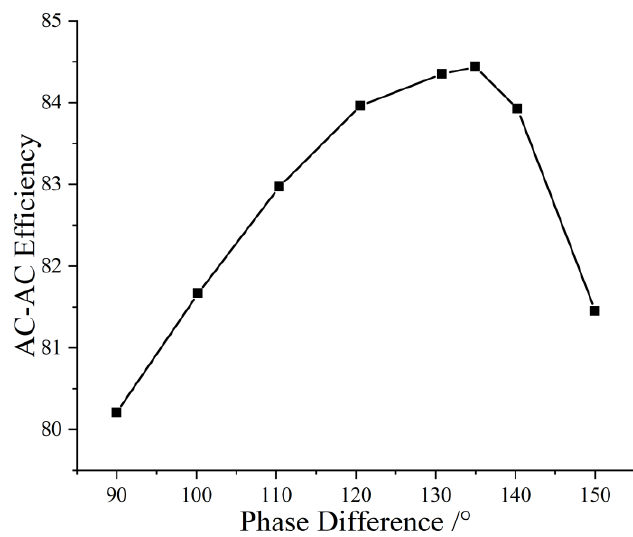
Figure 11. AC-AC efficiency varies with phase difference.